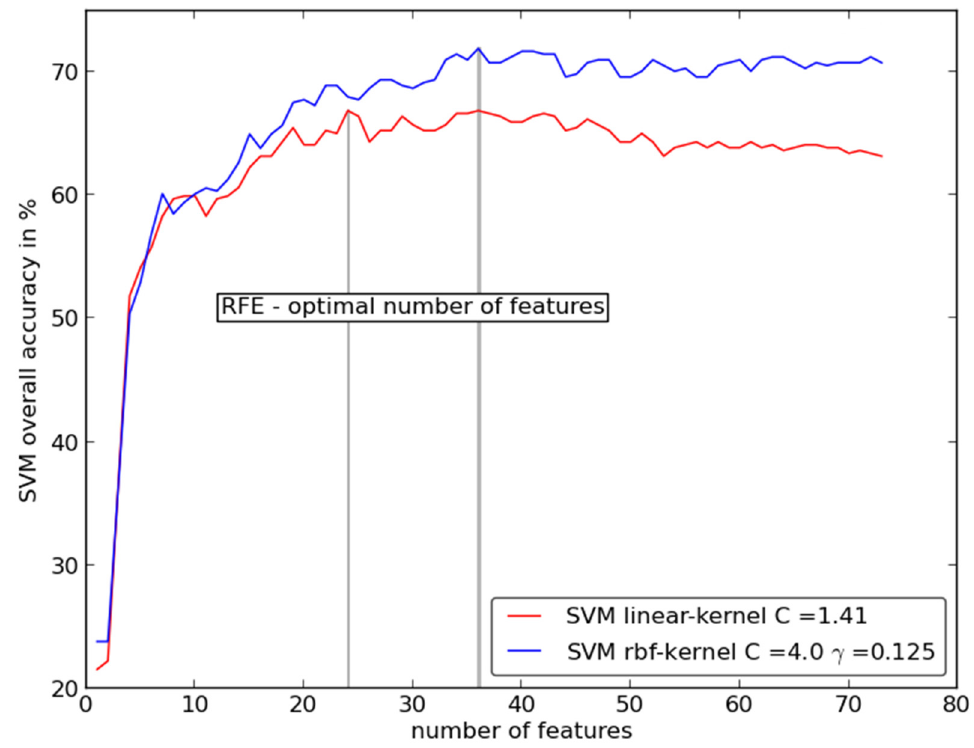
Figure 5. Accuracy curves from RFE for a linear and an